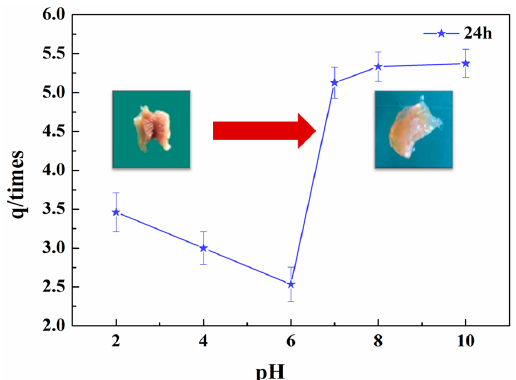
Figure 2. The pH-responsive swelling behaviors of PNIPAAm/chitosan hydrogel (at pH = 2–10) (swelling for 24 h in each buffer). Data are presented as mean ± standard deviation.